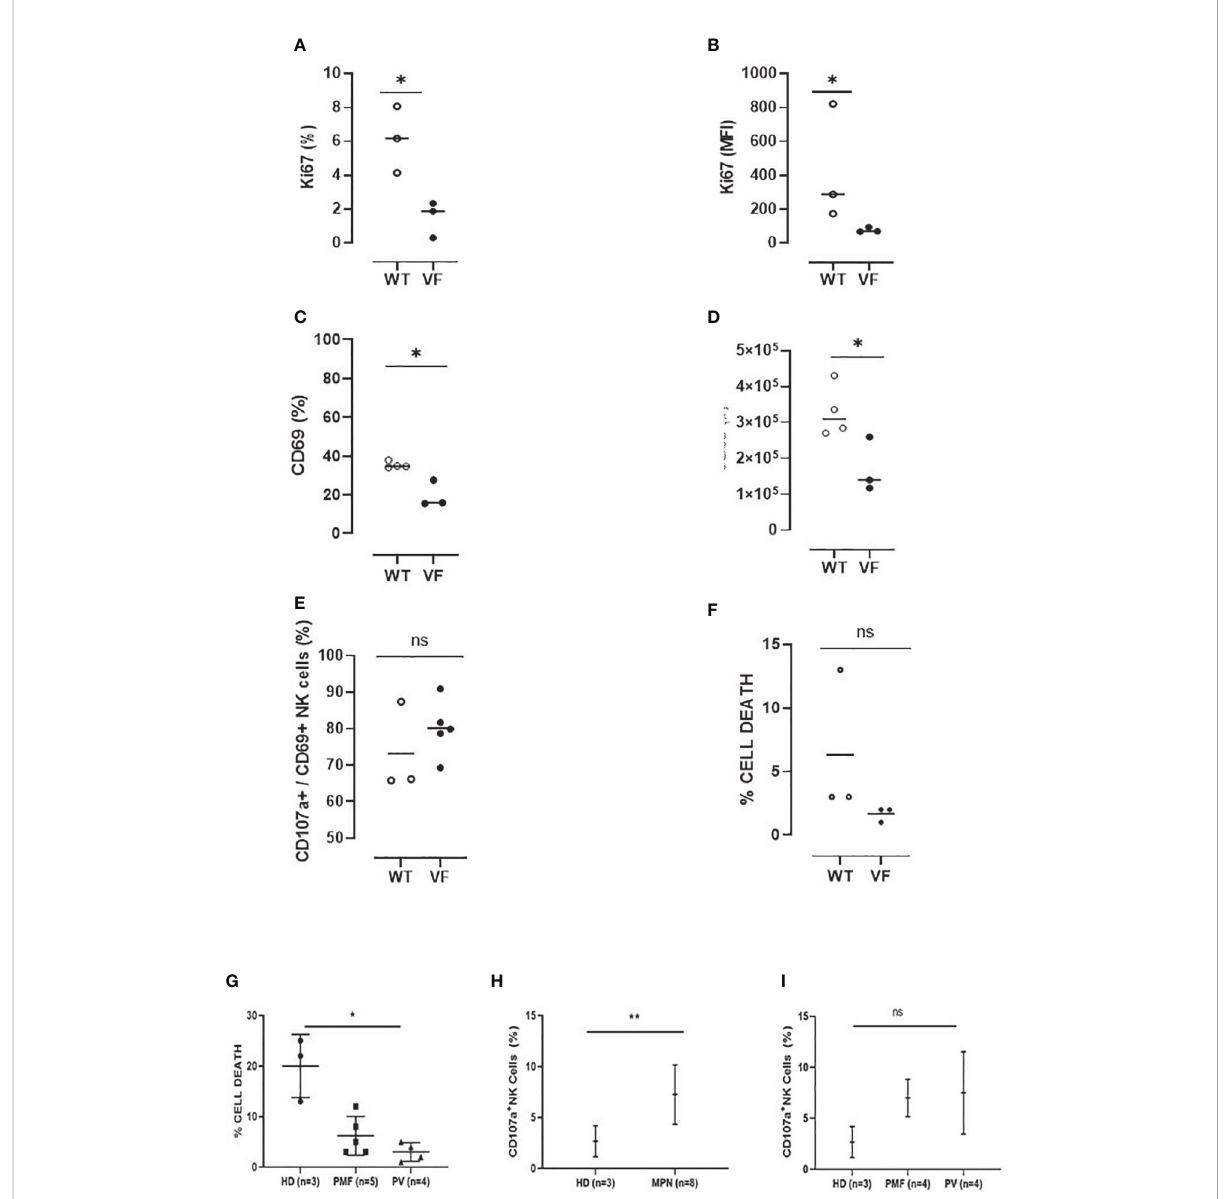
FIGURE 7 Murine and human NK cells from MPN present defective activation and cytotoxicity as compared to control NK cells. (A) The frequency and (B) mean fl uorescence intensity (MFI) of Ki-67 in Jak2WT (n = 4) and Jak2VF (n = 3) NK cells after 72 h of culture in the presence of IL-2. (C) The proportion and (D) number of activated Jak2WT and Jak2VF NK cells (CD69 + ). (E) The frequency of CD69+ NK cells expressing the degranulation marker CD107a after 3 h of stimulation with YAC-1. (F) The frequency of cell death after YAC-1 stimulation. (G) The frequency of cell death and (H – I) NK degranulation in myeloproliferative neoplasms with JAK2V617F mutation (VF) or not (WT), measured by CD107a expression after stimulation with the K562 target cell. VF, Jak2V617F mutated; WT, Jak2 wild-type; CTRL, control (n = 3); MPN, myeloproliferative neoplasms (n = 9); PV, polycythemia vera (n = 4); PMF, primary myelo fi brosis (n = 5). Error bars indicate the mean (± SEM). NS, not signi fi cant (p > 0.05); *p < 0.05; **p < 0.01; Mann – Whitney and Kruskal – Wallis